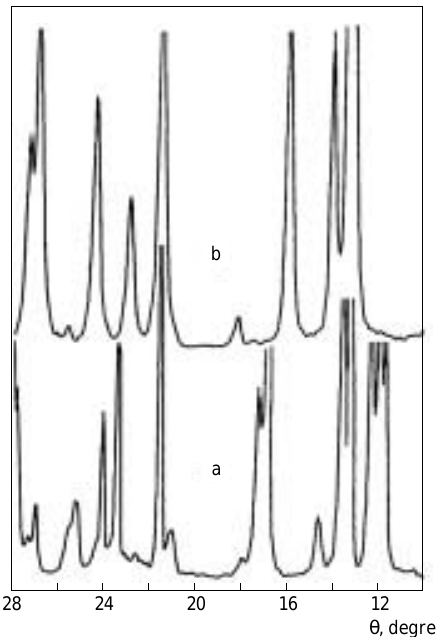
Fig. 20 X-ray patterns of an initial mixture of barium peroxide with WO 3 (a), after its mechanical activation for 5 min. (b).